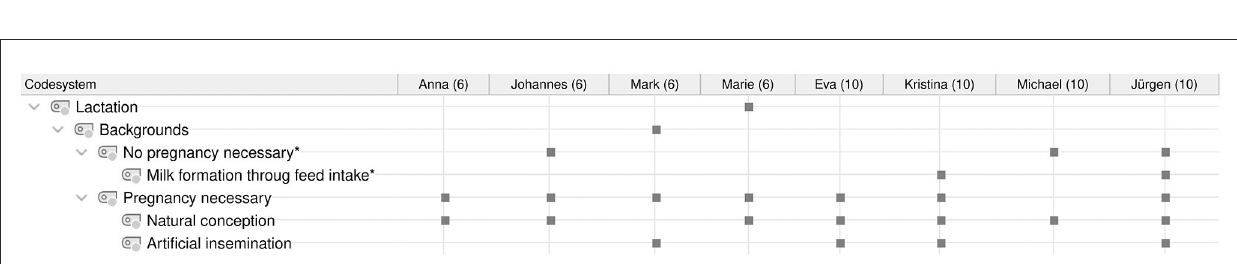
FIGURE7 Overview of the students’ statements on the reasons for milk production. * Inductively coded categories. The marks by the categories indicate that they were named by the